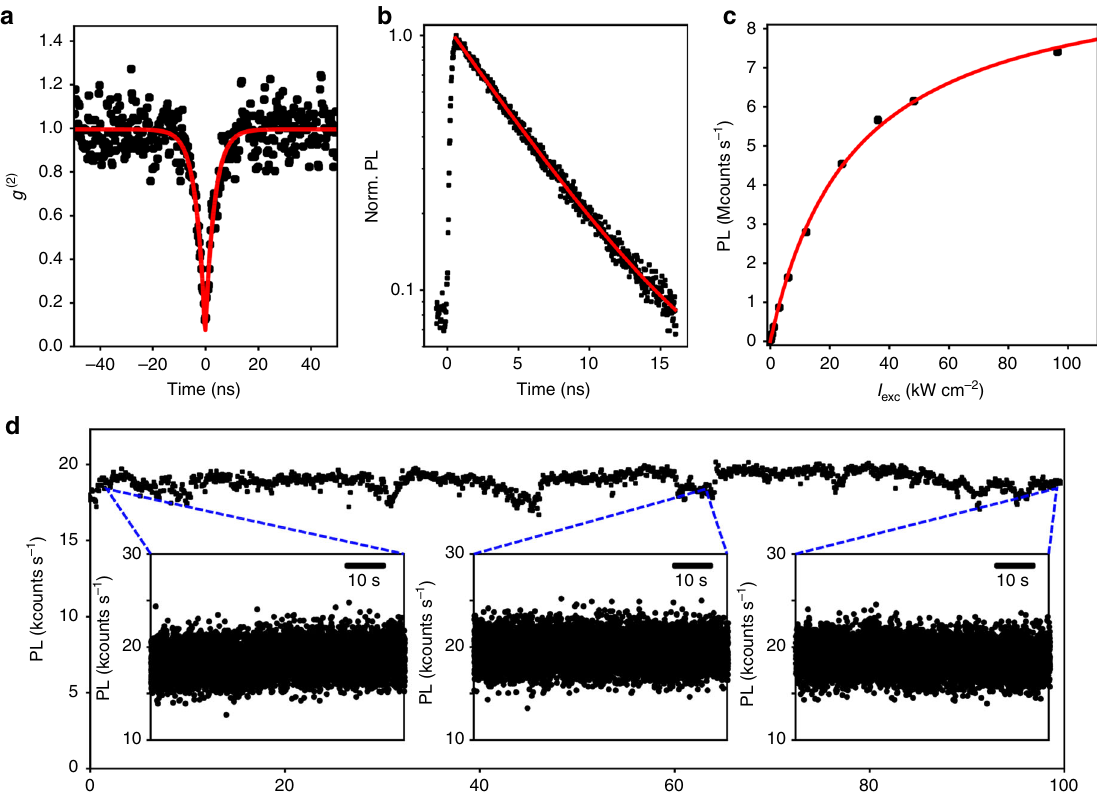
Fig. 2 Photophysics of a single GQD. a Second-order correlation function g (2) ( τ ) recorded from a diffraction limited spot such as the one of Fig. 1 (black dots), showing a strong antibunching. A fi t (red line) with a function 1 (cid:1) ð 1 (cid:1) b Þ e (cid:1)j τ j = τ 1 yields g (2) (0) = 0.05 ± 0.05 and a characteristic time of τ 1 ∼ 3.5 ns (FWHM of the IRF of the detector ∼ 0.9 ns). b Time-resolved PL of a single GQD (black dots) detected on the whole spectrum, fi tted by a mono- exponential decay (red line) with a time constant τ = 5.37 ns. c Saturation curve of a single GQD (black dots) as a function of the pump power. A fi t by Eq. (1) (red line) leads to a saturation power density of 28 kW cm − 2 and a saturation intensity I sat ∼ 9.7 Mcounts/s. d PL time trace of a stable GQD over 100 min with a binning time of 200 ms. Fluctuations are due to setup instabilities. Zooms are shown on shorter timescale with a binning time of 10